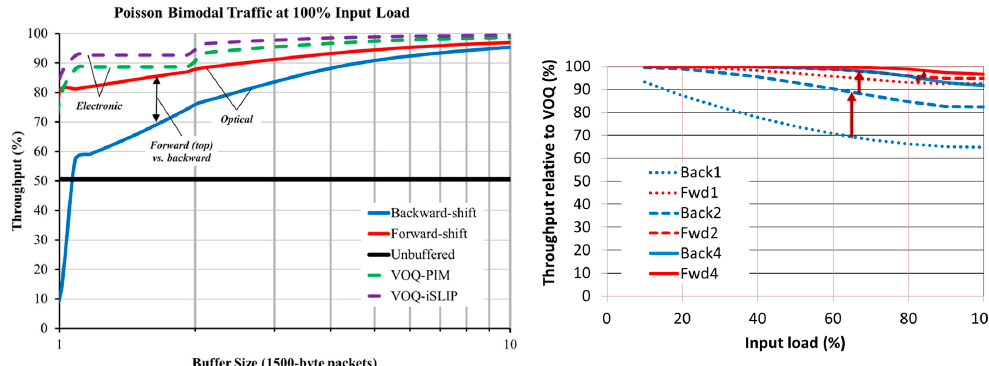
Figure 17. Forward shift ( top solid curve) achieves throughput efficiency approaching that of electronic routers and can be over 93% efficient (95% as efficient as electronic VOQ show as dashed curves, right curve) with as few as 6000 bytes of SDL buffering. Forward shift is much more effective than backward shift for most nontrivial buffer sizes (over 1070 bytes).